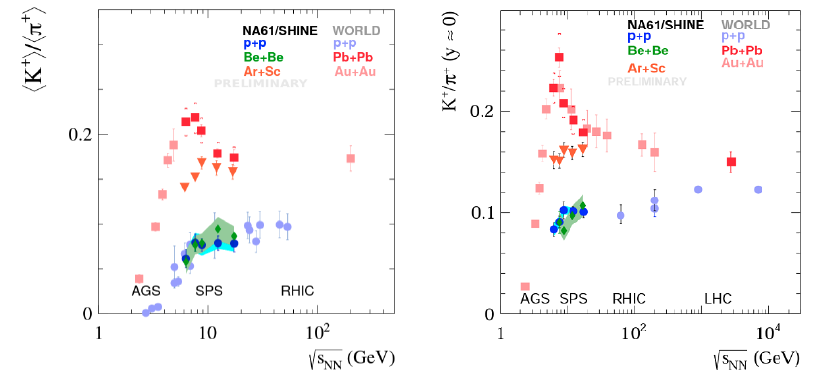
Figure 3. ⟨ K + ⟩ / ⟨ π + ⟩ ratio in full 4 π phase space ( left ) and ⟨ K + ⟩ / ⟨ π + ⟩ ratio at mid-rapidity ( right ) as a function of collision energy for p + p, Be + Be, Ar + Sc and Pb + Pb / Au + Au collisions.